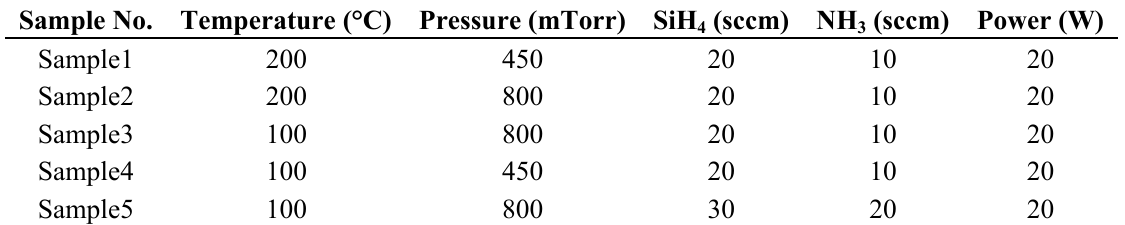
Table 1. Plasma enhanced chemical vapor deposition (PECVD) deposition parameters of the SiN thin films. x